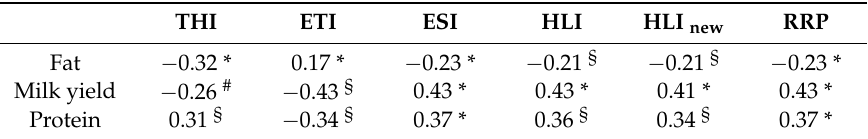
Table 2. Correlation between climate indices (THI, ETI, ESI, HLI, HLI new, and RRP) and milk compounds (fat, milk yield, and protein) in summer (* is p -value < 0.05, § is p -value < 0.1 and # is not significant). Taken from [2,4]. THI ETI ESI HLI HLI new RRP Fat ´ 0.32 * 0.17 * ´ 0.23 * ´ 0.21 § ´ 0.21 § ´ 0.23 * Milk yield ´ 0.26 # ´ 0.43 § 0.43 * 0.43 * 0.41 * 0.43 * Protein 0.31 § ´ 0.34